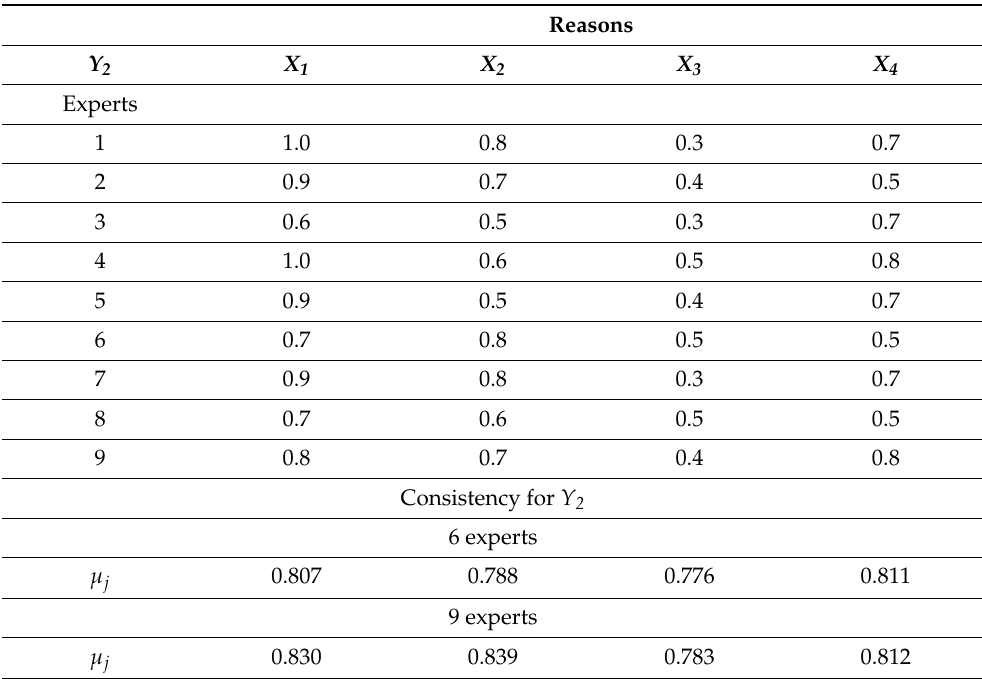
Table 2. Expert evaluations for the second parameter.